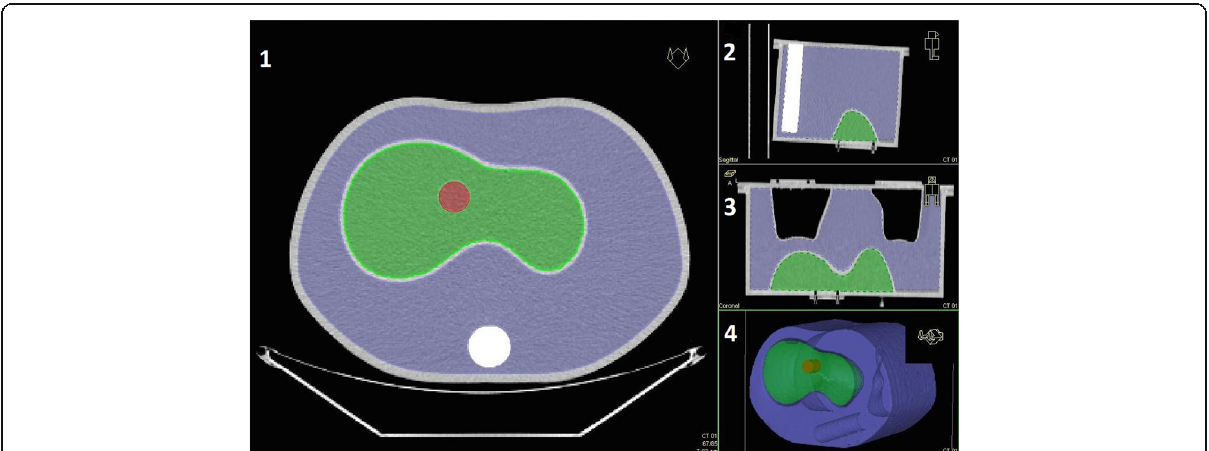
Fig. 3 Anthropomorphic phantom used to validate the PET camera ’ s ability to produce 90 Y quantitative data. The phantom is composed by a background region (10,300 mL), a liver compartment (1200 mL), left (900 mL) and right lung (1100 mL), and a spine insert (200 mL). A homemade cylindrical PMMA insert was manufactured and fixed into the liver cavity to simulate a hepatic lesion. The nominal volume of the insert is 19.13 mL (diameter 28.5 mm, height 30 mm)